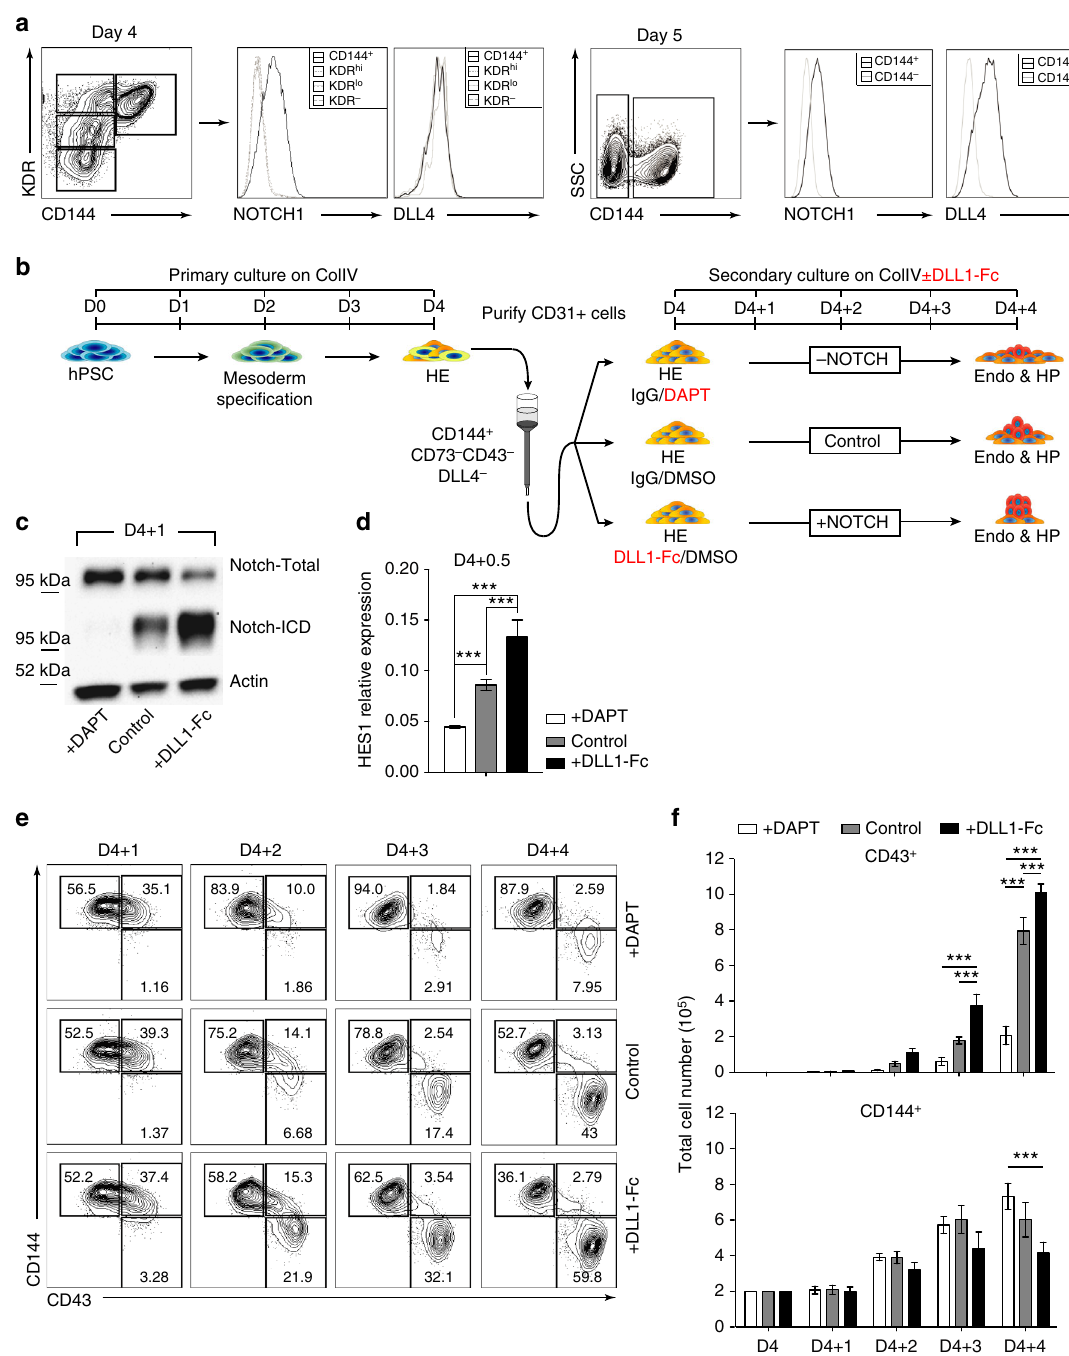
Fig. 1 NOTCH activation increases hematopoiesis from D4 HE. a NOTCH1 receptor expression is fi rst detected on D4 CD144 + cells. DLL4 expression is fi rst detected on D5 CD144 + endothelial cells. b Schematic diagram of experiments. Cells were differentiated for 4 days on collagen IV, D4 CD144 + CD43 − CD73 − HE cells were puri fi ed using CD31 microbeads and plated in 3 different NOTCH conditions. c Western blot of D4 HE cultured for 24 h (D4 + 1) in presence of DAPT or DLL1-Fc shows a decrease in the activated cleaved form of NOTCH1 in DAPT-treated cells, and an increase in the activated cleaved form of NOTCH1 in cells plated on DLL1-Fc. d qPCR analysis shows decreased HES1 mRNA expression in D4 HE cultured for 12 h (D4 + 0.5) with DAPT, while HES1 mRNA expression is increased in cells plated on DLL1-Fc. Results are mean ± s.e.m. for three independent experiments; two-way ANOVA Bonferroni post-hoc test, *** p < 0.01. e Flow cytometry on each day from D4 + 1 to D4 + 4 shows decreased CD43 + HPs in the cultures treated with DAPT, and increased HPs in the cultures plated on DLL1-Fc. Representative contour plots from three independent experiments are shown. f Total numbers of CD43 + HPs and CD144 + CD43 − endothelial cells in cultures plated on DLL1-Fc. Results are mean ± s.e.m. for three independent experiments; two-way ANOVA Bonferroni post-hoc test, *** p <